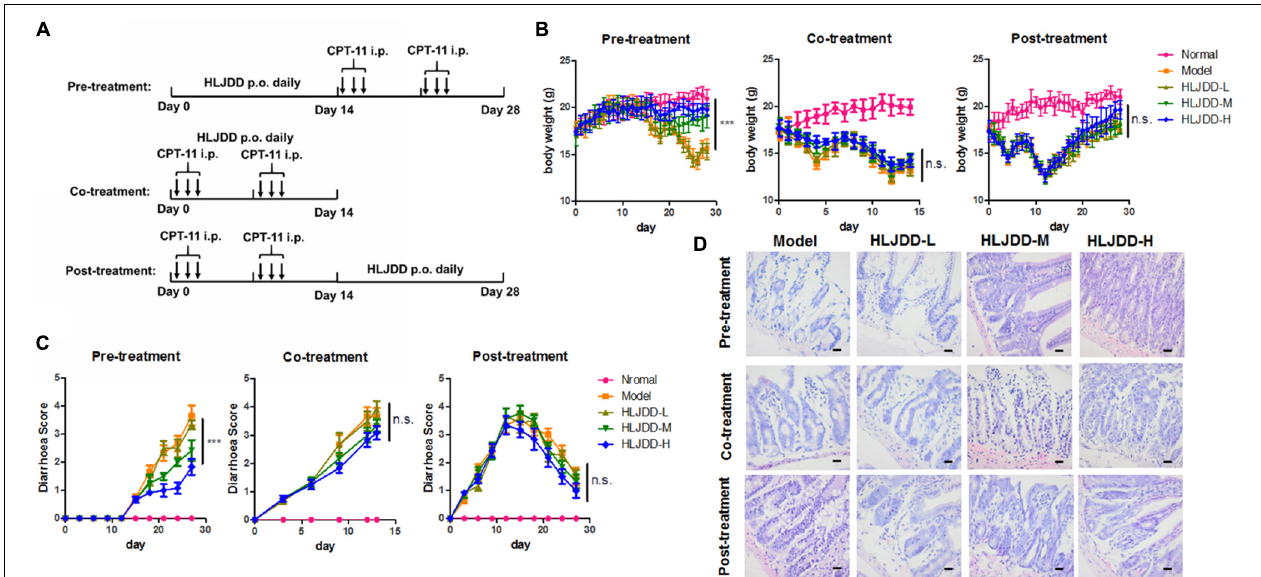
FIGURE 3 | Pre-treatment but not co-treatment or post-treatment of HLJDD improved CPT-11-induced diarrhea. (A) Showed the treatment scheme; (B) showed that pre-treatment but not co-treatment or post-treatment of HLJDD improved body weight loss induced by CPT-11; (C) showed that pre-treatment but not co-treatment or post-treatment of HLJDD improved diarrhea score induced by CPT-11; (D) showed that pre-treatment but not co-treatment or post-treatment of HLJDD improved the histological structure of jejunum damaged by CPT-11. *** p < 0.001 when compared with the model group.